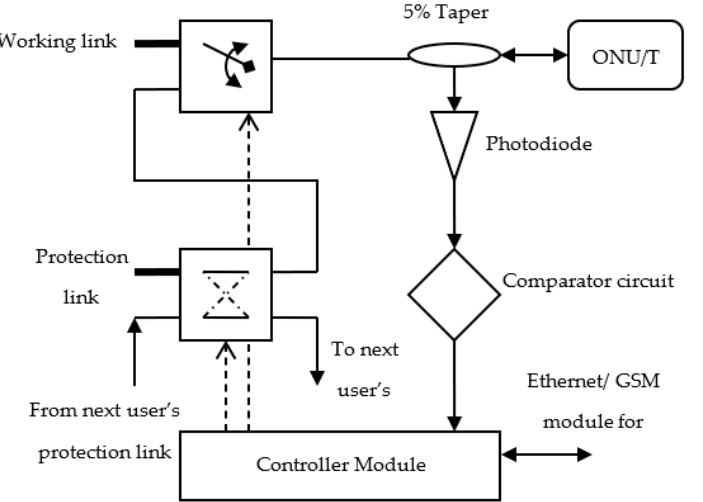
Figure 12. The modified PROMO architecture.